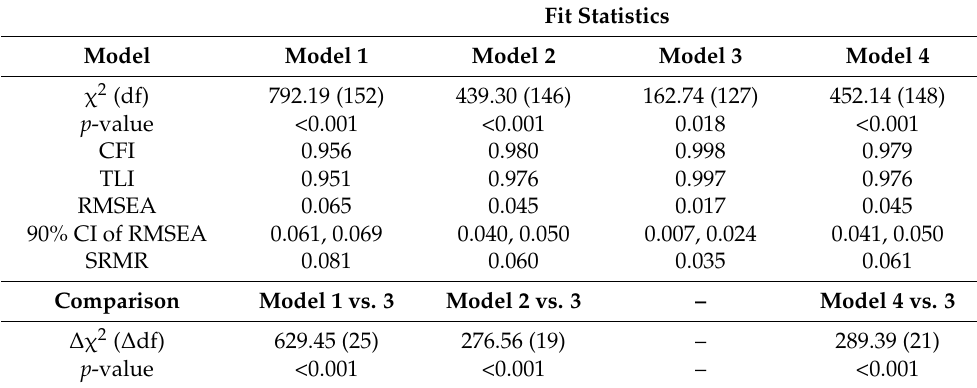
Table 3. Model comparisons for the Sexual Orientation Microaggression Inventory